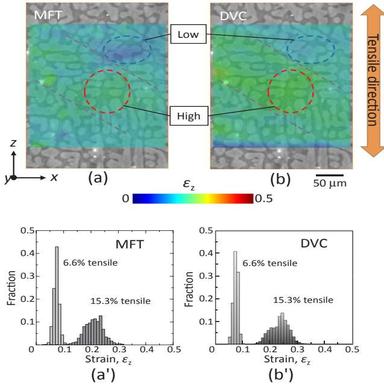
Comparison of strain maps, εz obtained by (a) MFT and (b) DVC in 15.3% tensiled specimen in Al-7mass%Si cast alloy with intermetallic compound (Al-Si-Sr) particles. (a′) and (b′) show bar charts of the strain distribution for 6.6% and 15.3% tensile strain determined by MFT and DVC.